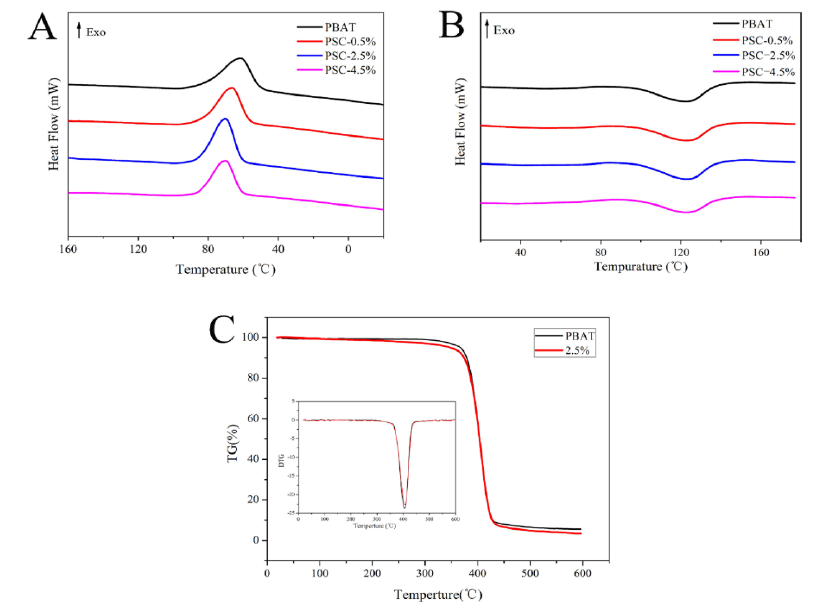
Figure 8. ( A ): Differential scanning calorimetry (DSC) non-isothermal crystallization curve of PBAT and PSC films; ( B ): DSC melting curve of PBAT and PSC films; ( C ): Thermogravimetric curve of films (within derivative thermogravimetric curve). Table 3. DSC parameters of PBAT and PSC films.